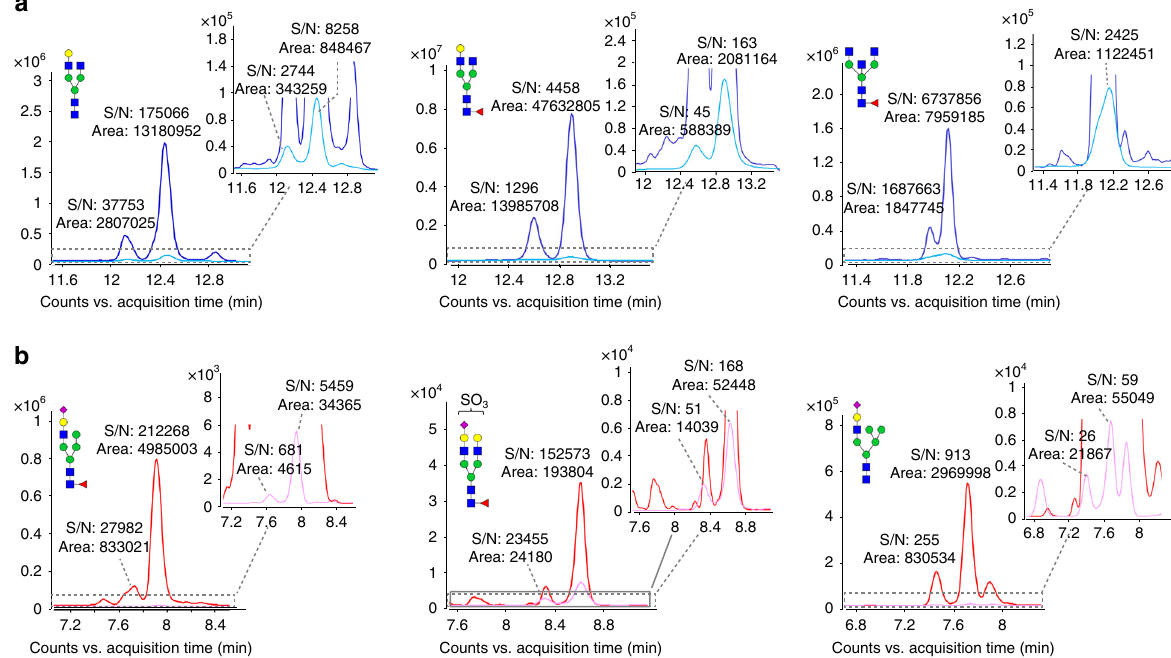
Fig. 5 Improved detection of N-glycans using the MRM method. N-glycans were detected using Q-TOF MS ( pale blue or pale red ) and QQQ MS (MRM mode, blue or red ). The improved detection of representative neutral N-glycans Hex 4 HexNAc 4 , Hex 4 HexNAc 4 dHex 1 and Hex 3 HexNAc 5 dHex 1 are shown in a , and the improved detection of representative sialylated N-glycans Hex 5 HexNAc 3 dHex 1 NeuAc 1 , Hex 5 HexNAc 4 dHex 1 NeuAc 1 + SO 3 and Hex 6 HexNAc 3 NeuAc 1 are shown in b . The signal intensities of N-glycans obtained using the MRM method were increased by up to 180-fold compared with those obtained with Q-TOF MS. Notably, the S/N of the acidic N-glycans obtained using MRM increased by ~10-fold to 1000-fold compared with that obtained with Q-TOF